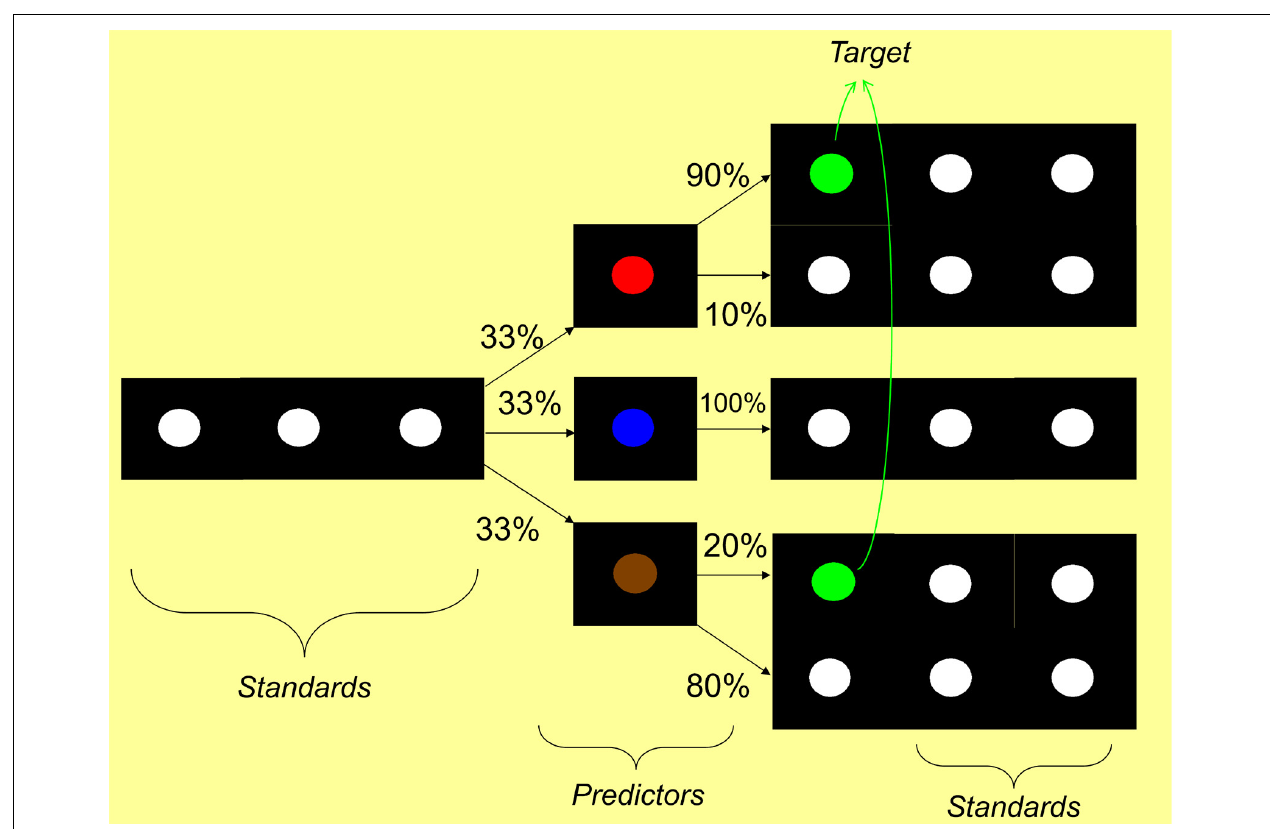
the trials by the target, and a “zero probability” predictor, which is never followed by the target. Participants are not told about these predictor-target variable statistical contingencies. SL is observed behaviorally when performance improves with higher statistical contingency. SL is observed neurophysiologically when the ERP to the predictors differ between the experimental conditions (e.g., a larger amplitude for the high probability predictor compared to the other two predictor